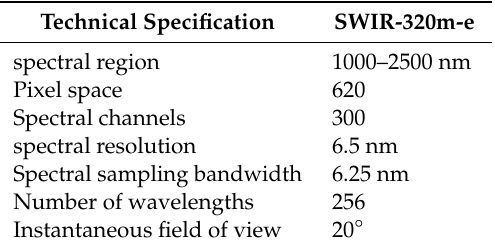
Table 1. Main technical parameters of HySpex imaging